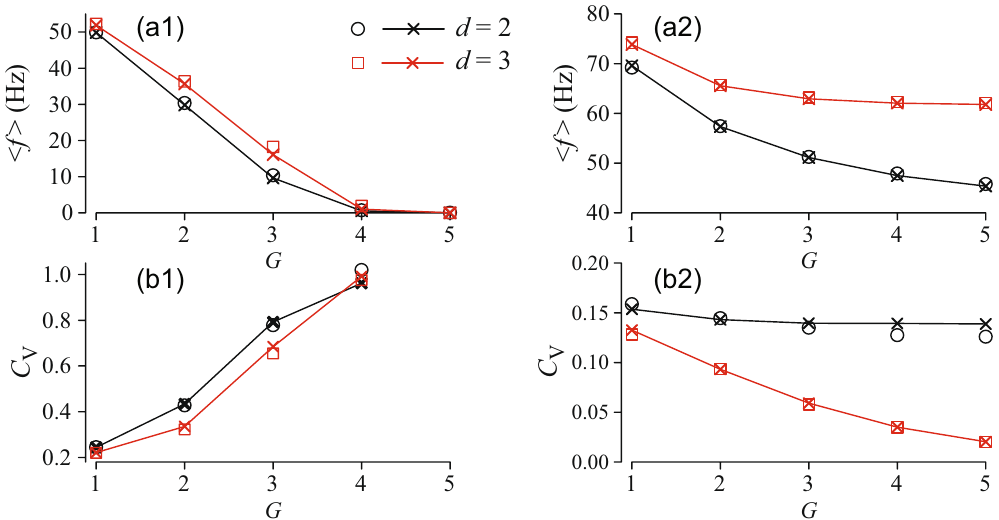
Figure 5. Mean firing rate, 〈 f 〉 , (a1, a2) and coefficient of variation, C V , of interspike intervals (b1, b2) of the central node versus the number of generations of tree networks in the strong coupling regime, κ = 1000 mS/cm 2 and noise intensity D = 500 ( μ A/cm 2 ) 2 ms. Left panels (a1, b1) correspond to an excitable tree with constant current I = 35 μ A/cm 2 ; right panels (a2, b2) refer to an oscillatory tree with I = 60 μ A/cm 2 . Symbols  and ○ mark results of numerical simulations of the corresponding network with the indicated branching, d ; solid lines and symbols × show theoretical scaling